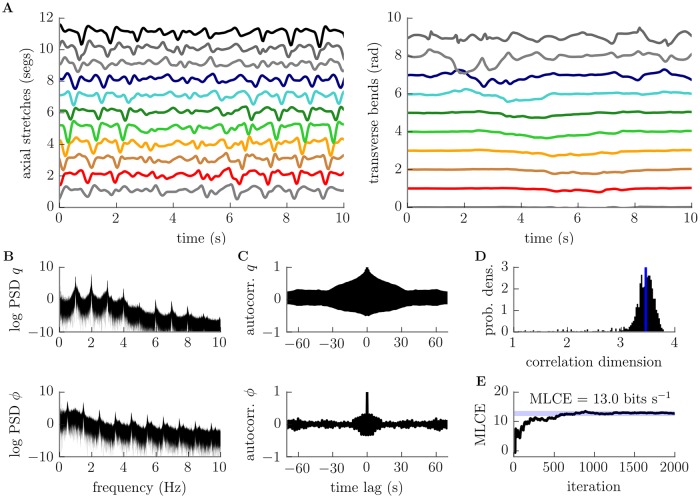
Dissipative planar motion is chaotic.A: representative segmental stretch (left) and bend (right) time series (see S3 Fig for corresponding neural state). Note the occurence of a large bend starting at ∼ 1–2 seconds at the larva’s head, which appears to propagate backwards along the body while triggering a “transition” from forward to backward wave propagation at ∼ 3.5 seconds. Forward wave propagation resumes at ∼ 6 seconds. B: power spectra of the head stretch q (top) and bend ϕ (bottom) showing significant “noise” component. C: Autocorrelations of q and ϕ rapidly decay. D: probability density of correlation dimension estimates for 1000 mechanical trajectories. The dimension of the system’s limit set is estimated as ∼ 3.5 (median, vertical blue line). E: maximum Lyapunov characteristic exponent estimates converge to a positive value. All measures suggest the presence of deterministic chaotic dynamics. Parameters used to generate this figure are given in S5 Table.